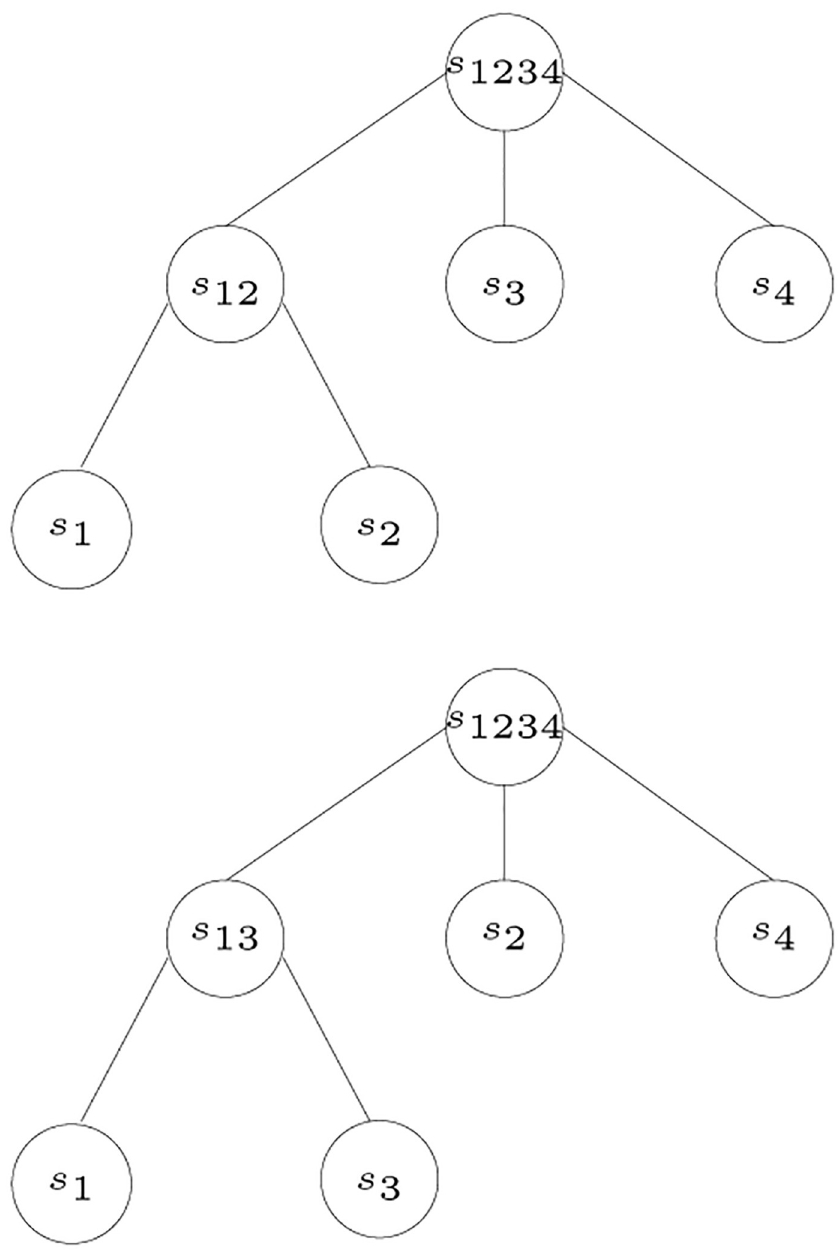
Fig 24. Two contradicting